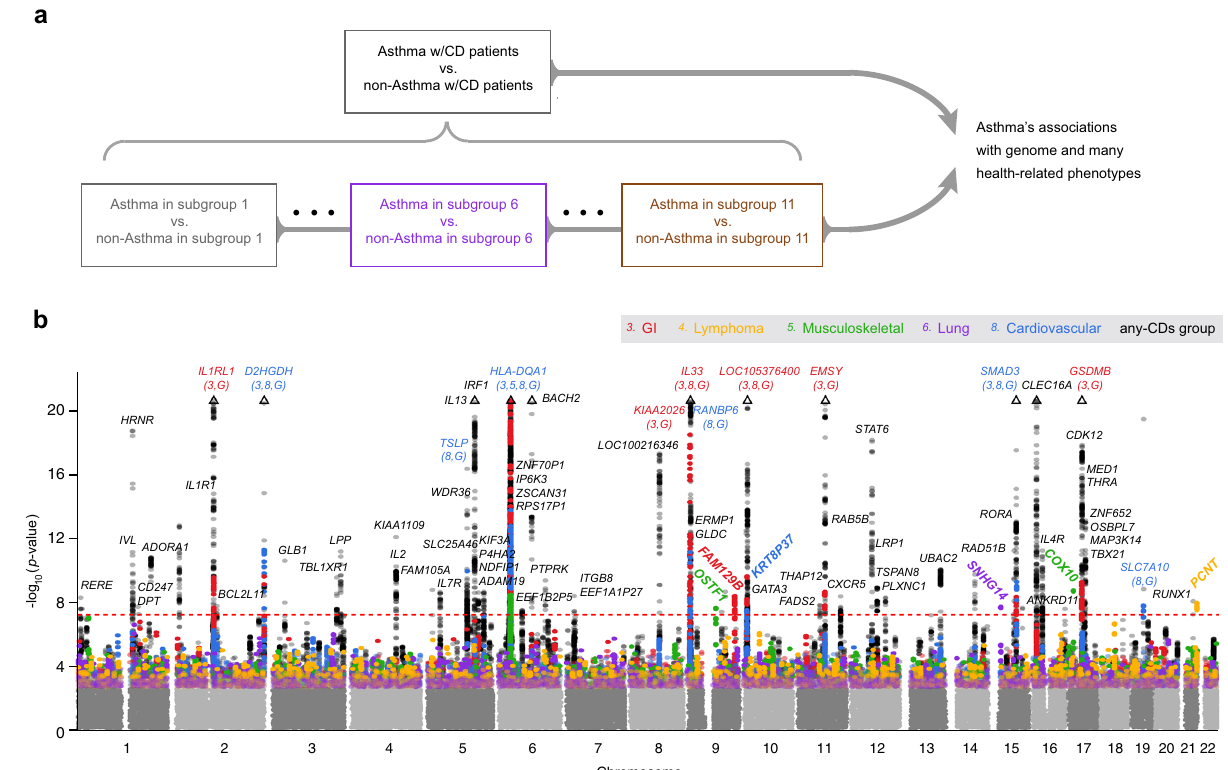
“ Cardiovascular. ” All the association p values are shown on a – log 10 scale on the y axis,andgenomiclocationsareshownonthe x -axis.Thethresholdofgenome-wide signi fi cance(5×10 − 8 )isindicatedasahorizontaldashedlineinred.Trianglesattop indicate SNPs that have a higher – log 10 ( p value) than shown. In addition, we annotategenome-widesigni fi cantlociwiththenamesoftheirnearestgenes,andin thecasewhereageneiscommonlyfoundinmultiplesubgroupsandintheany-CDs group, the subgroup serial numbers and letter “ G ” are written, respectively, in parentheses under the gene name. In particular, we highlight the genes nearest to the six subgroup-speci fi c loci by rotating their names with an angle of 45 degrees. More details can be found in Supplementary Table